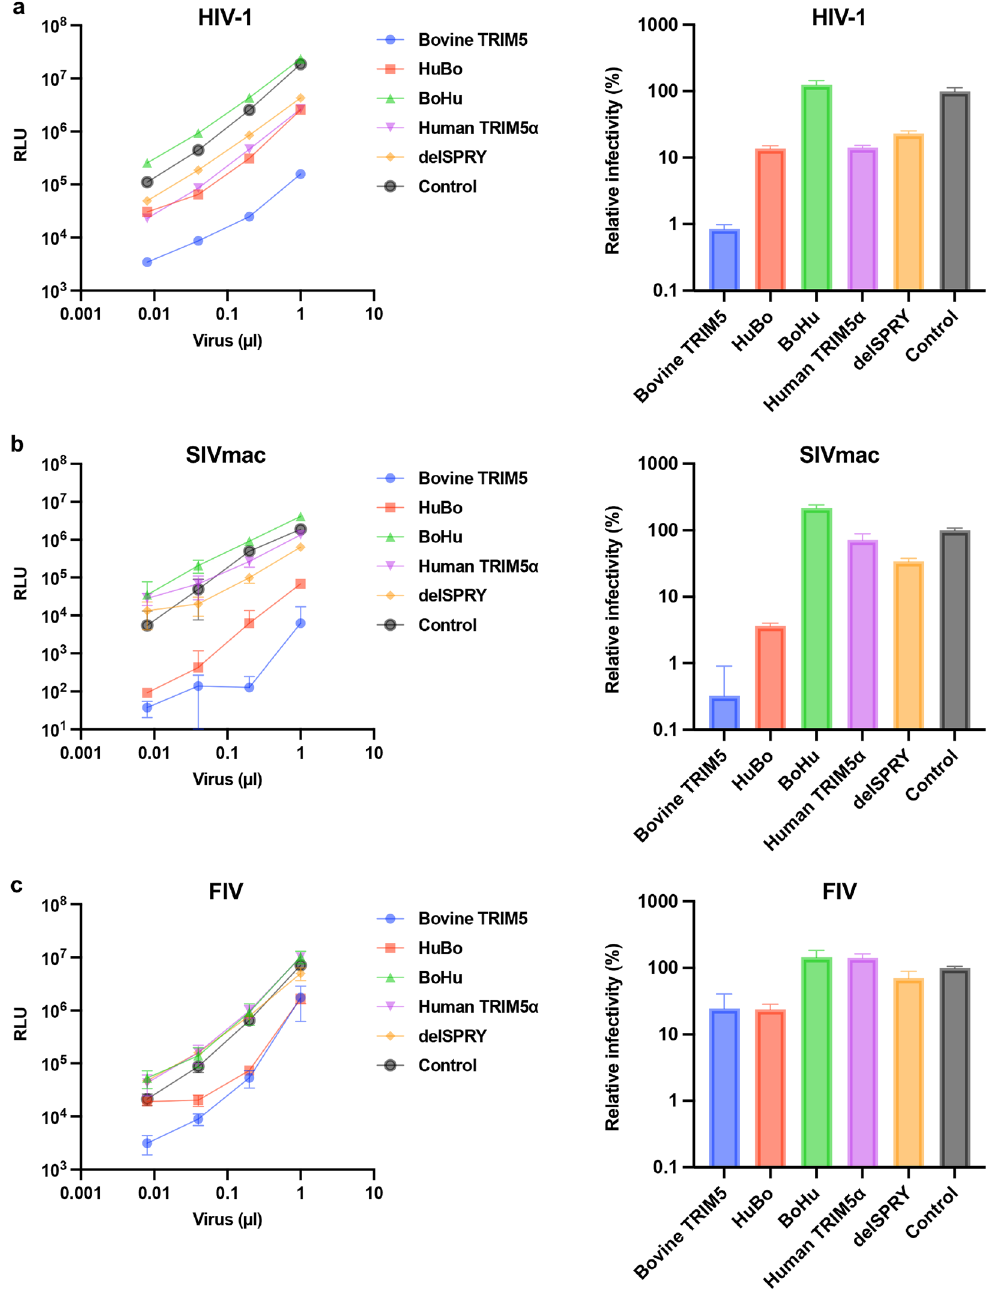
Figure 3. The SPRY domain of bovine TRIM5 is the determinant of anti-lentiviral activity. ( a ) (left) CRFK cells expressing TRIM5 proteins were infected with an HIV-1 vector encoding luciferase reporter protein. The infectivity was determined as relative light units (RLU) 2 days after infection. (right) Relative infectivity was calculated using the values in the left panel. ( b ) (left) CRFK cells expressing TRIM5 proteins were infected with an SIVmac vector encoding luciferase reporter protein. The infectivity was determined as relative light units (RLU) 2 days after infection. (right) Relative infectivity was calculated using the values in the left panel. ( c ) (left) CRFK cells expressing TRIM5 proteins were infected with an FIV vector encoding luciferase reporter protein. The infectivity was determined as relative light units (RLU) 2 days after infection. (right). Relative infectivity was calculated using the values in the left panel. ( d ) (left) CRFK cells expressing TRIM5 proteins were infected with an EIAV vector encoding luciferase reporter protein. The infectivity was determined as relative light units (RLU) 2 days after infection. (right) Relative infectivity was calculated using the values in the left panel. ( e ) (left) CRFK cells expressing TRIM5 proteins were infected with an MLV vector encoding luciferase reporter protein. The infectivity was determined as relative light units (RLU) 2 days after infection. (right) Relative infectivity was calculated using the values in the left